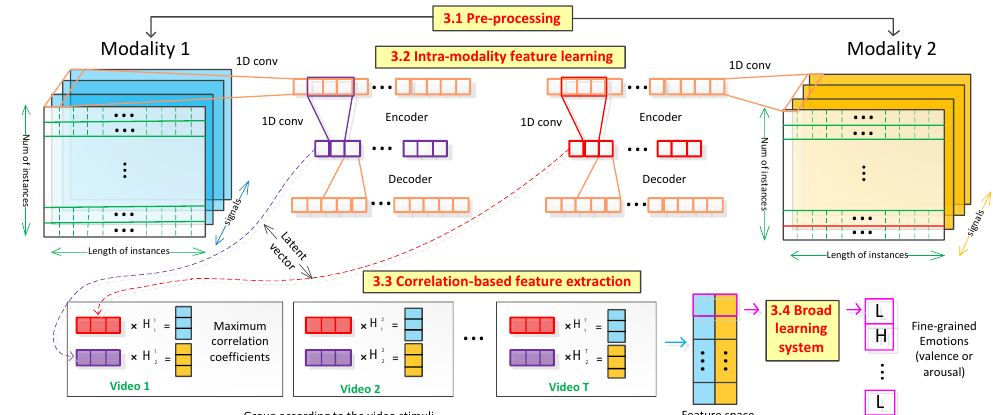
Figure 1. The procedure of proposed